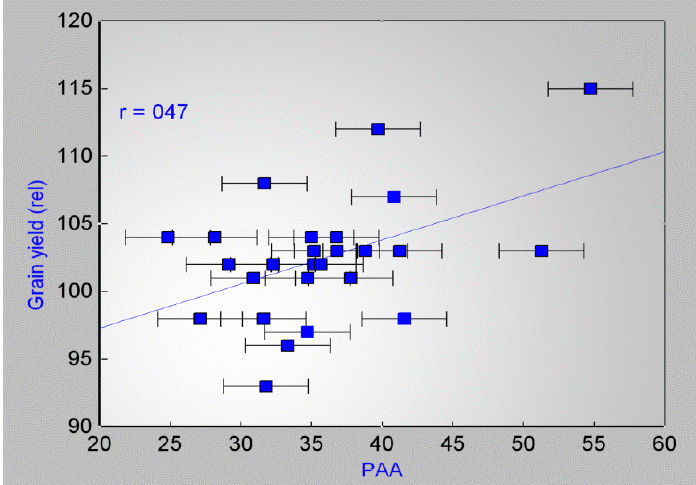
Figure 5. Relationship between potential allelopathic activity (PAA) and grain yield in Swedish official variety tests of winter wheat cultivars. Bars indicate two standard errors (SE). r denotes the linear correlation coefficients and is significant if r > 0.38 ( P <